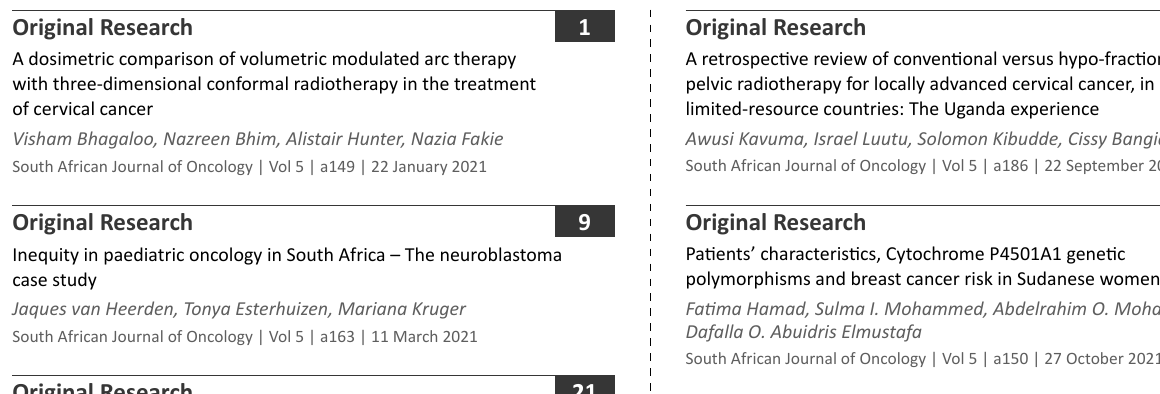
Original Research A dosimetric comparison of volumetric modulated arc therapy with three-dimensional conformal radiotherapy in the treatment of cervical